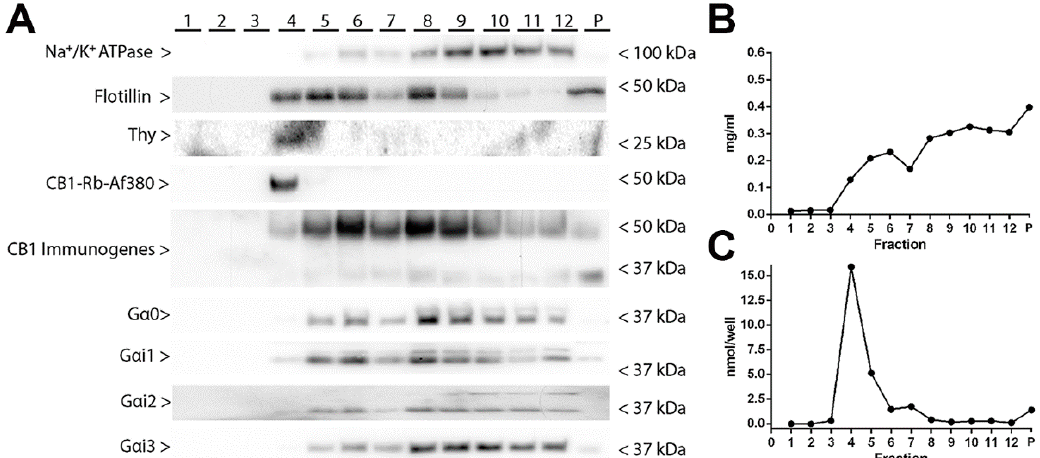
Figure 3. Alkaline phosphatase enzymatic activity, total protein amount and distribution of raft and non-raft markers in lipid raft and non-lipid raft fractions isolated from frontal cortical synaptosomes derived from wild-type mice. ( A ) Representative Western blots running in parallel same volume (20 µL/lane) of the collected 12 fractions and of the pellet (P). Immunoblot against Na + /K + -ATPase, Flotillin, Thymocyte (Thy-1), CB1 receptor, and G α i/o subtypes. Protein migration was consistent with their expected molecular mass. For the CB1 receptor and the G α i2 protein, an extra band migrating at ~35 kDa and ~36 kDa was detected, respectively. Na + /K + -ATPase, 112.3 kDa; Flotillin, 47.5 kDa; thymocyte 1 (Thy-1), 18.1 kDa; CB1 receptor, 52.8 kDa; G α o 40.1 kDa; G α i1, 40.5 kDa; G α i2, 40.4 kDa; G α i3, 40.5 kDa. The molecular weights depicted correspond to the signal of the standard markers. ( B ) Total protein content of the collected 12 fractions and of the pellet (P). ( C ) Alkaline phosphatase activity of the collected 12 fractions and of the pellet (P).